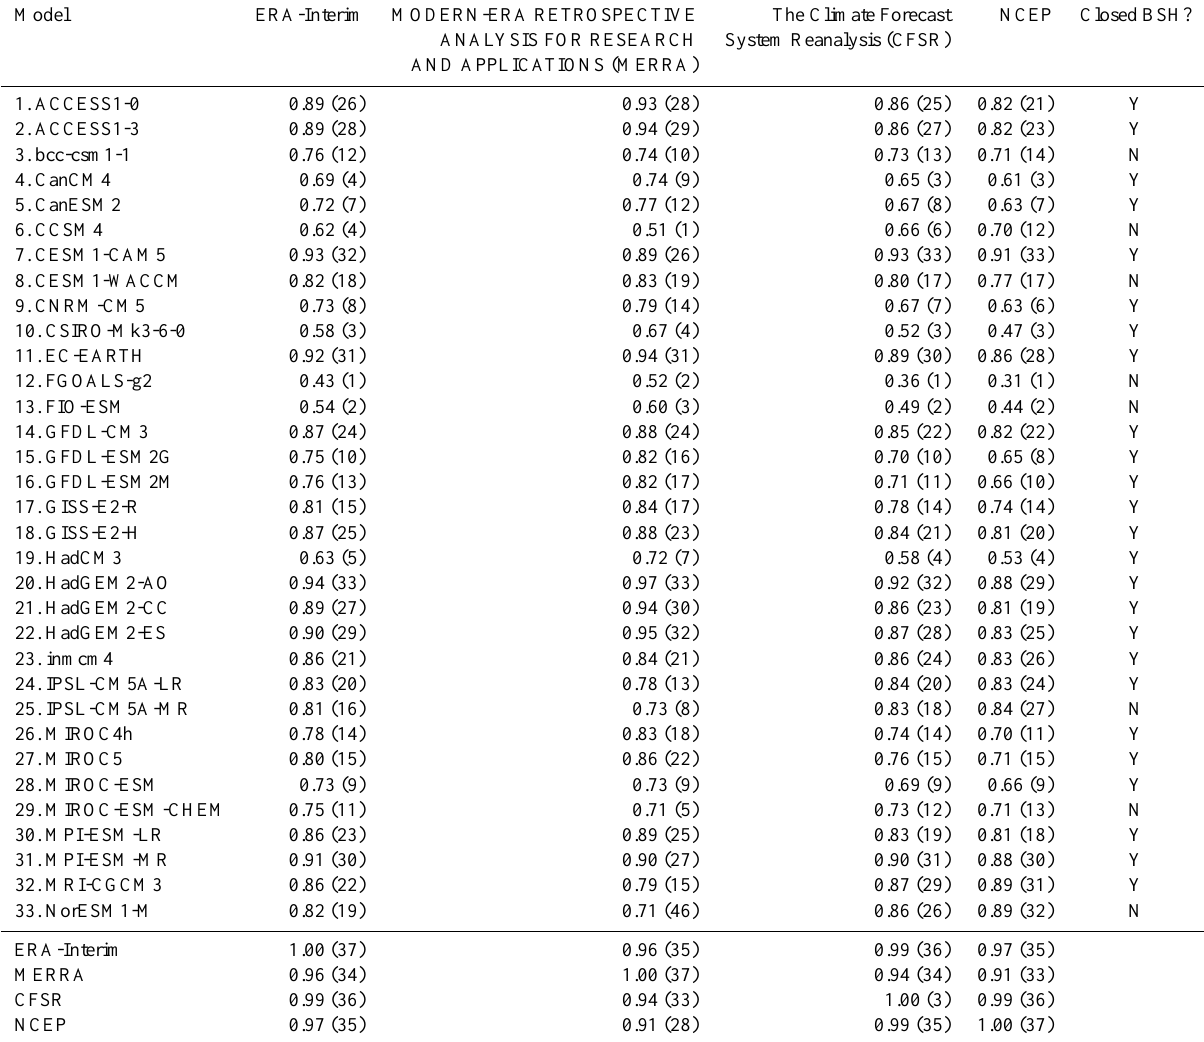
Table 3. Spatial correlations between observed mean annual sea level pressure from four different reanalysis data sets and from the CMIP5 models. Ranks of correlations are given in parentheses, running lowest to highest. Because of difficulties in reducing surface pressures to sea level, pressures over Greenland have been screened out. Correlations between the different reanalyses are also included as well as information on whether or not the models represent a closed Beaufort Sea High